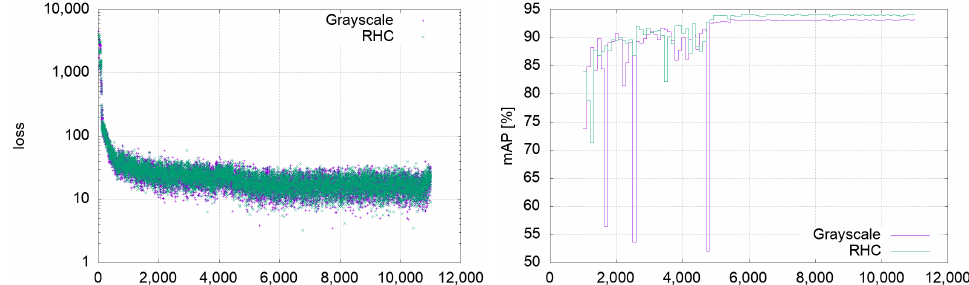
Figure 15. Learning curves for grayscale images and RHC images: in the left inset, the loss change; in the right inset, the actual mean average